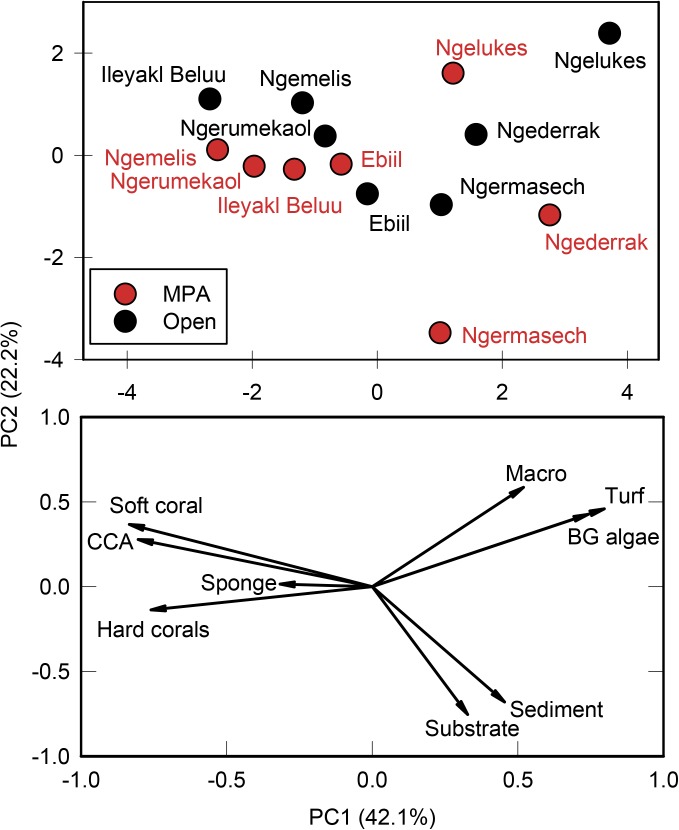
Principal component analysis (PCA) of major benthic groups from all sites.Percent cover data were arcsine square root transformed prior to analysis. Top figure shows site separation while lower figure shows drivers that explain the most variance in the principal components.